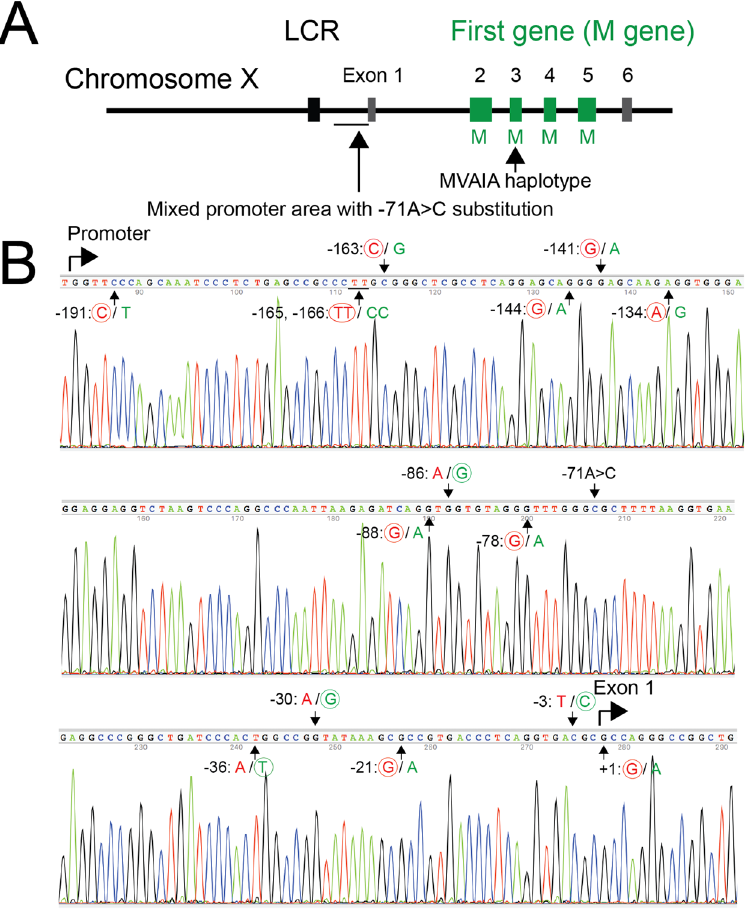
Figure 2. Genotype of Case 1. ( A ) Overview of the genotype of Case 1. Case 1 had an intact LCR and a single M gene array in which no aberrations were found. The promoter regions had a unique profile including a − 71 A > C substitution. ( B ) The promoter of the single M-gene array. Black arrows indicate the 14 nucleotides differing between first and downstream genes and the − 71 A > C substitution. At each position, the usual nucleotide of the first gene promoter is shown on the left side in red and that of the downstream gene promoter is shown on the right side in green. The nucleotides in Case 1 are